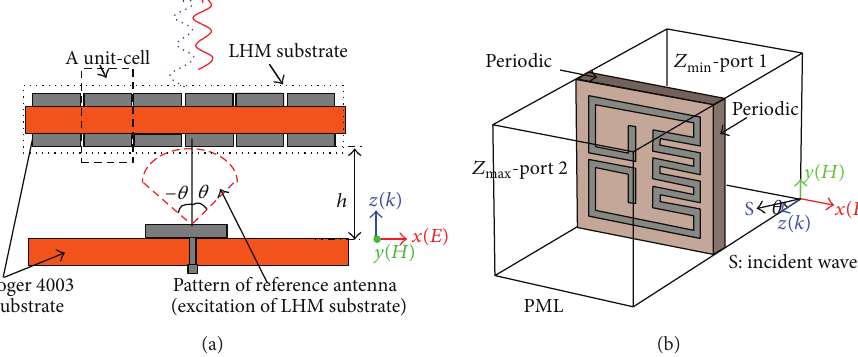
Figure 4: (a) FL-LHM antenna model which improves the antenna gain by FL-LHM substrate. The reference antenna makes excitation for FL-LHM substrate. The solid red line represents the forward wave and the dotted blue line indicates the wave reflected at the back FL-LHM. (b) Numerical FL-LHM unit-cell model for simulation.